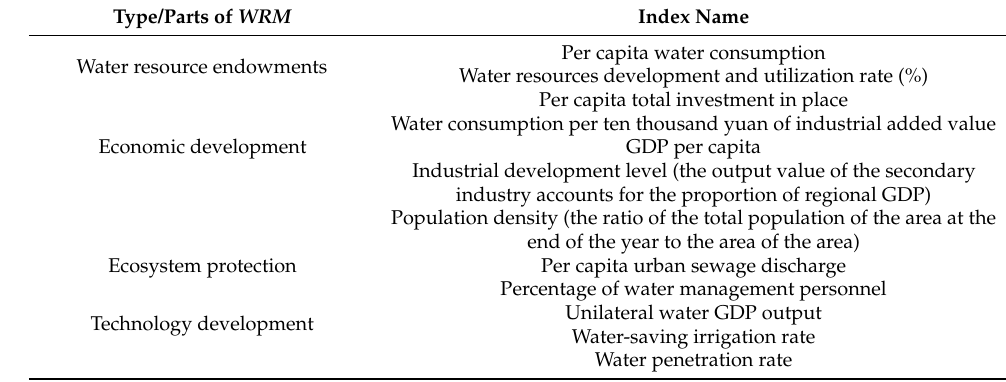
Table 2. The content and evaluation indicator system of WRM